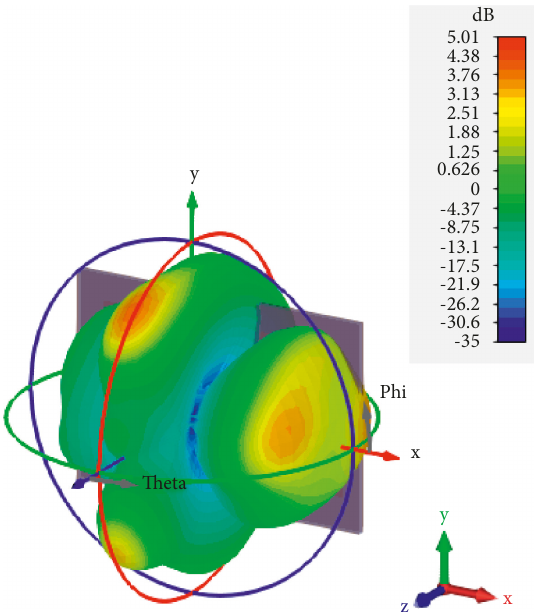
Figure 14: 3D Radiation pattern (1 × 2